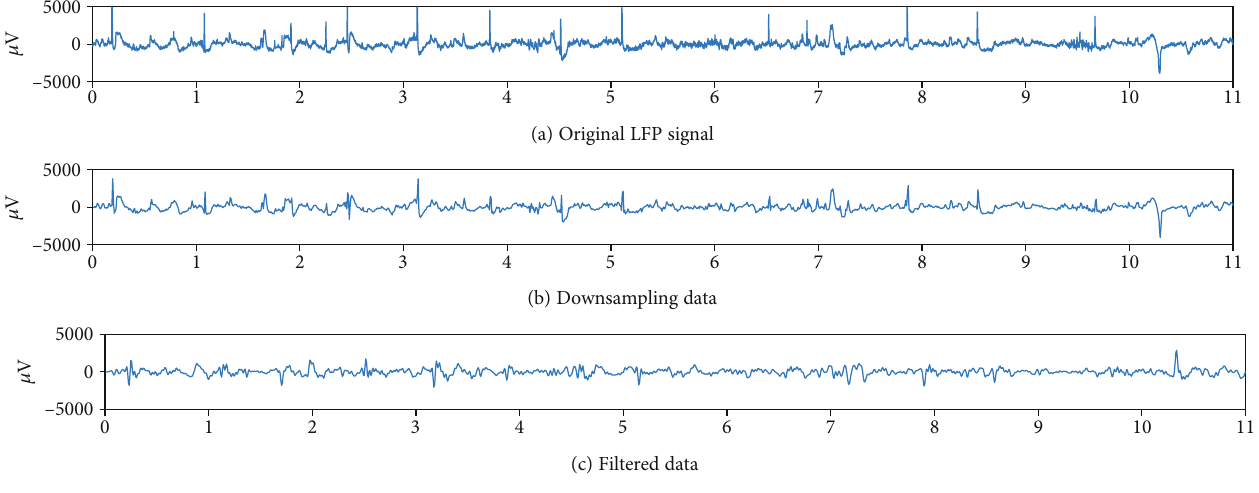
Figure 3: Randomly selected one channel, taking 11 seconds of LFP data to analyze and